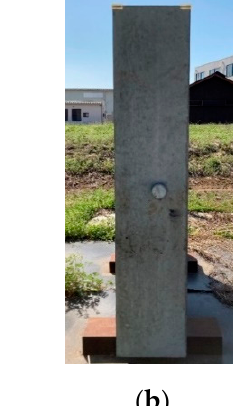
Figure 10. Photograph of the concrete specimen_1: ( a ) Front side of specimen; ( b ) Cross-section of specimen.